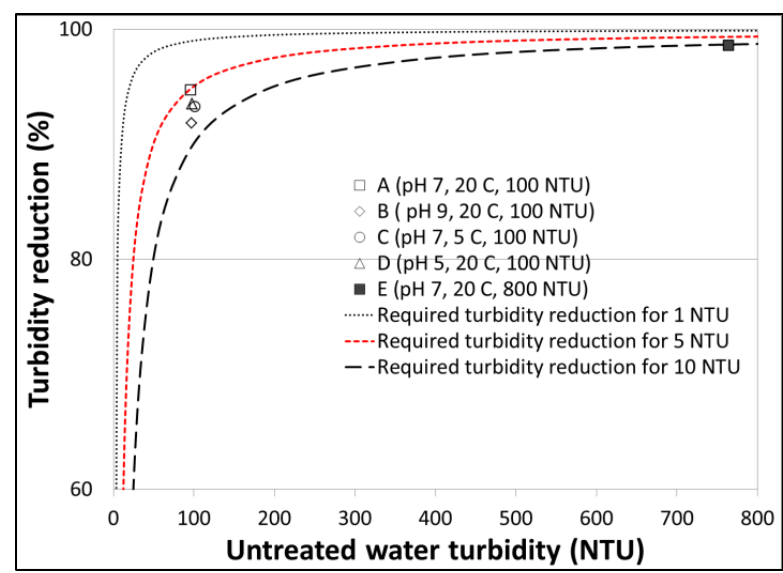
Figure 5. Average treated water turbidity reductions for test series A–E with required turbidity reductions to achieve specified treatment targets.